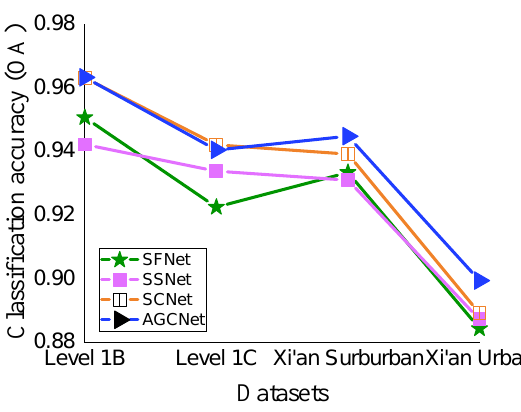
Figure 8. The classification accuracies with different number of training samples.